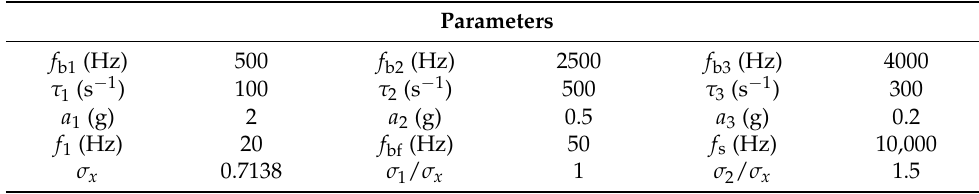
Table 1. Parameters of simulation